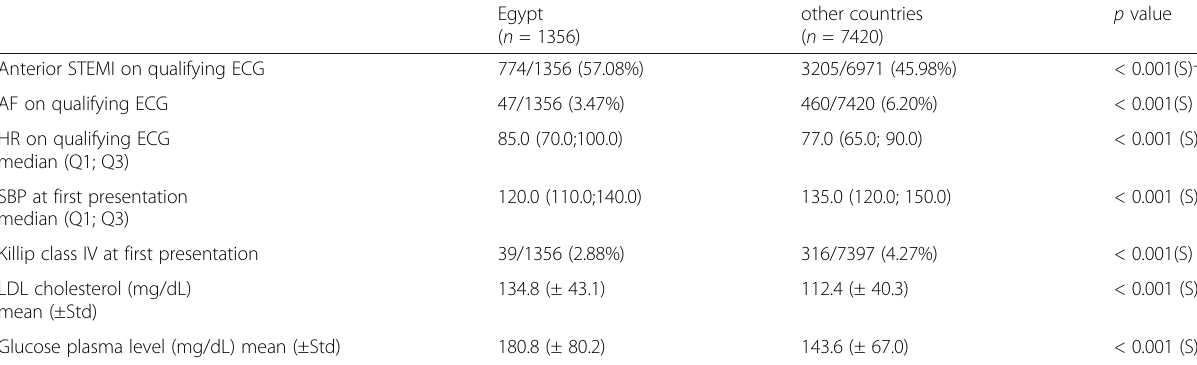
Table 2 Presentation and initial assessment; Egypt vs. other countries